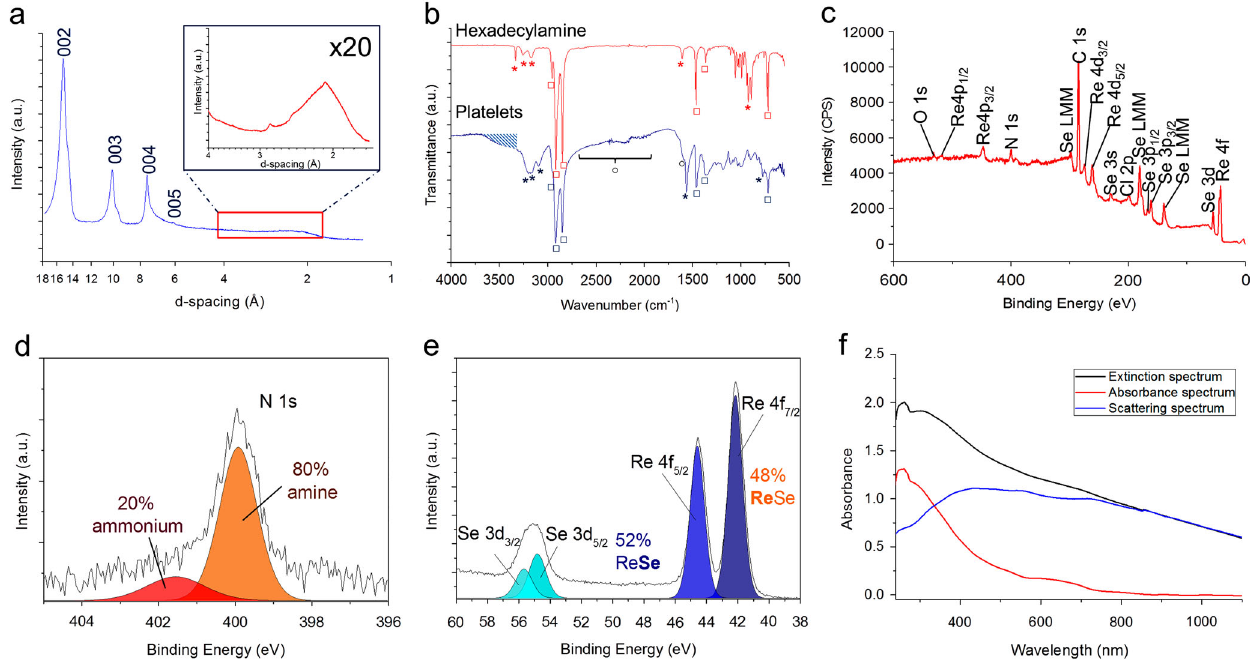
Fig. 3 XRD pattern of the platelets ( a ), FTIR comparison of neat amines and platelets ( b ), XPS survey ( c ) and XPS regions of N 1 s ( d ), Se 3 d and Re 4 f ( e ) acquired at high resolution and UV – vis spectrum of the platelets dispersed in IPA ( f